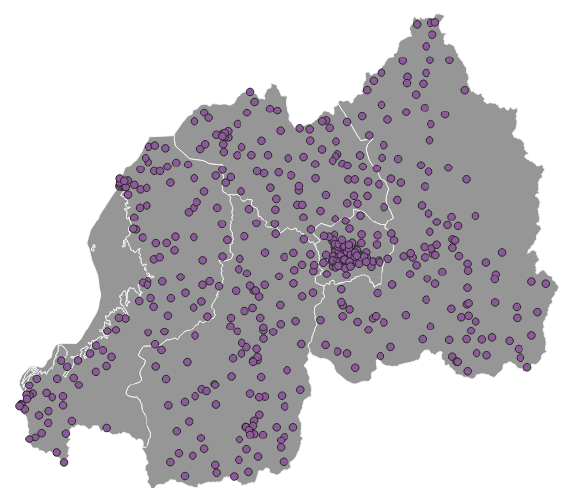
Figure 1. Locations of cell towers. Lines indicate the boundaries of the four provinces and the city of Kigali.